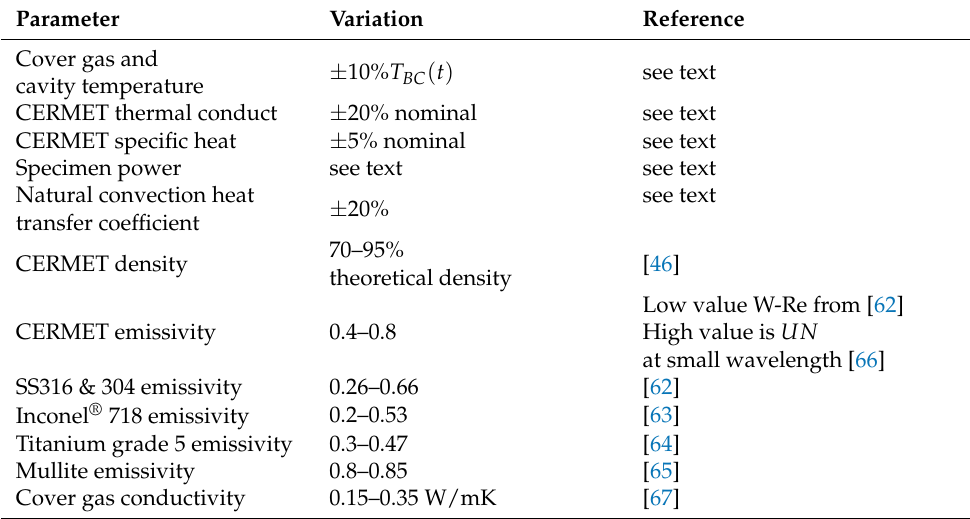
Table 5. Uncertain parameters of the SIRIUS-CAL experiment thermal-hydraulics model.